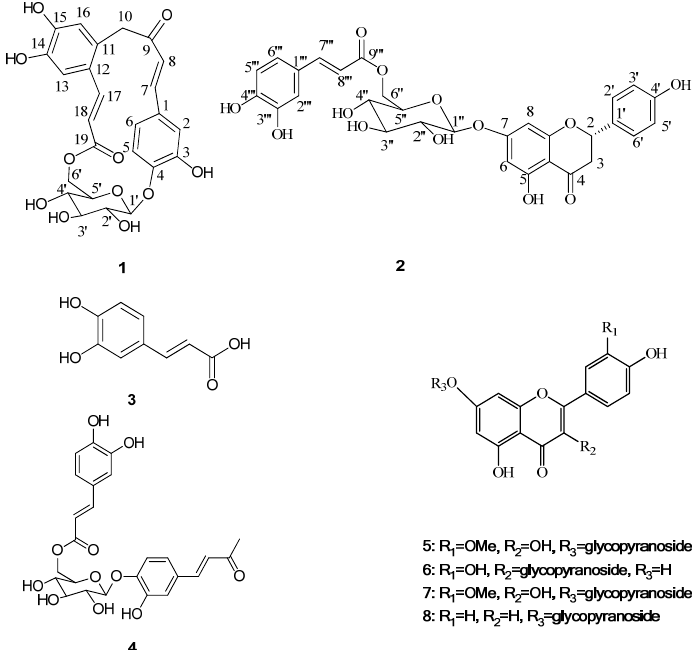
Figure 1. Structures of compounds 1 – 8